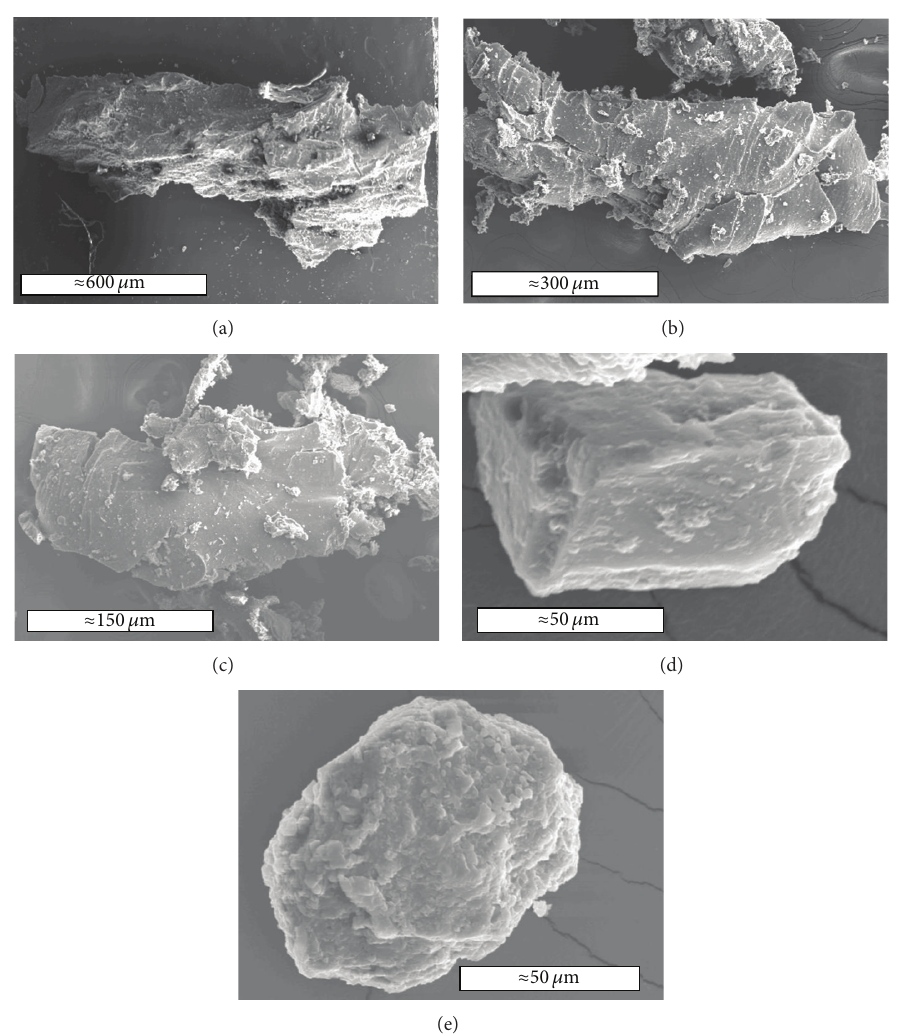
Figure 4: Scanning Electron Microscopy (SEM) pictures for different sizes of crumb rubber particles: (a) #4 ∼ #20; (b) #20 ∼ #200; (c) #4 ∼ #200; (d) #100 ∼ #200; (e) #100 ∼